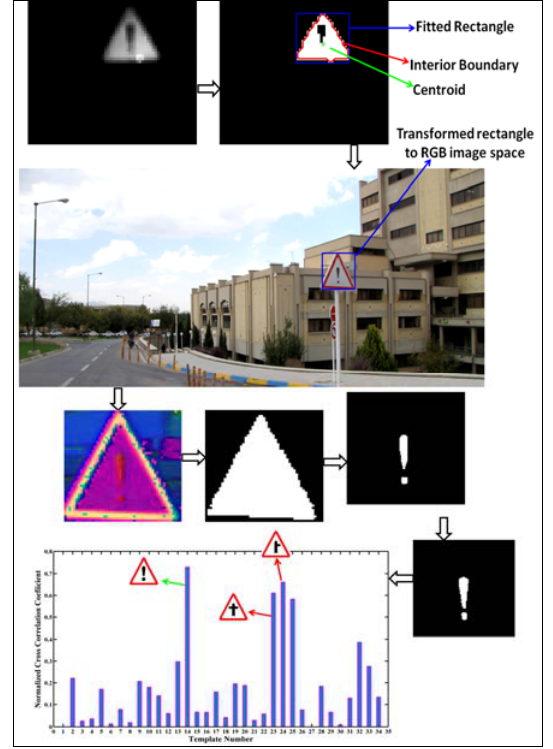
Figure 5. The DRL process applied to a triangular signs